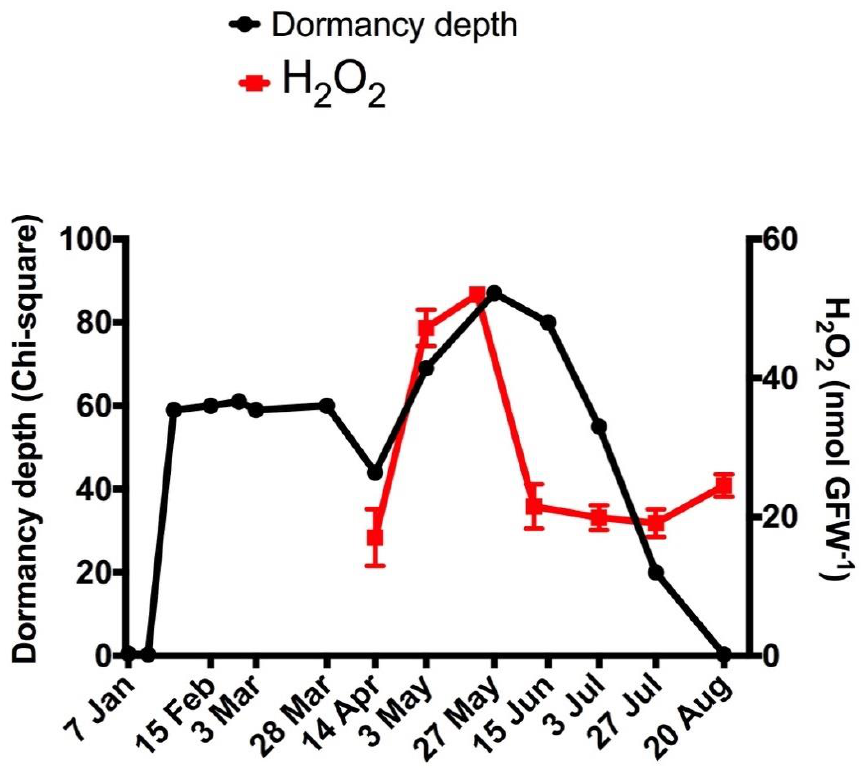
Figure 1. Relationship between the degree of endodormancy and H 2 O 2 levels in Thompson seedless grapevine buds grown in Santiago, Chile. The degree of dormancy was determined by means of a log-rank test between the probabilistic function KM of the buds collected before (reference) and after the onset of the ED [26]. H 2 O 2 was determined by a chemiluminescence method [29].